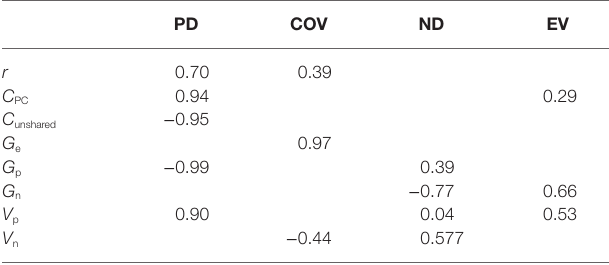
TABLE 5 | Latent factors.